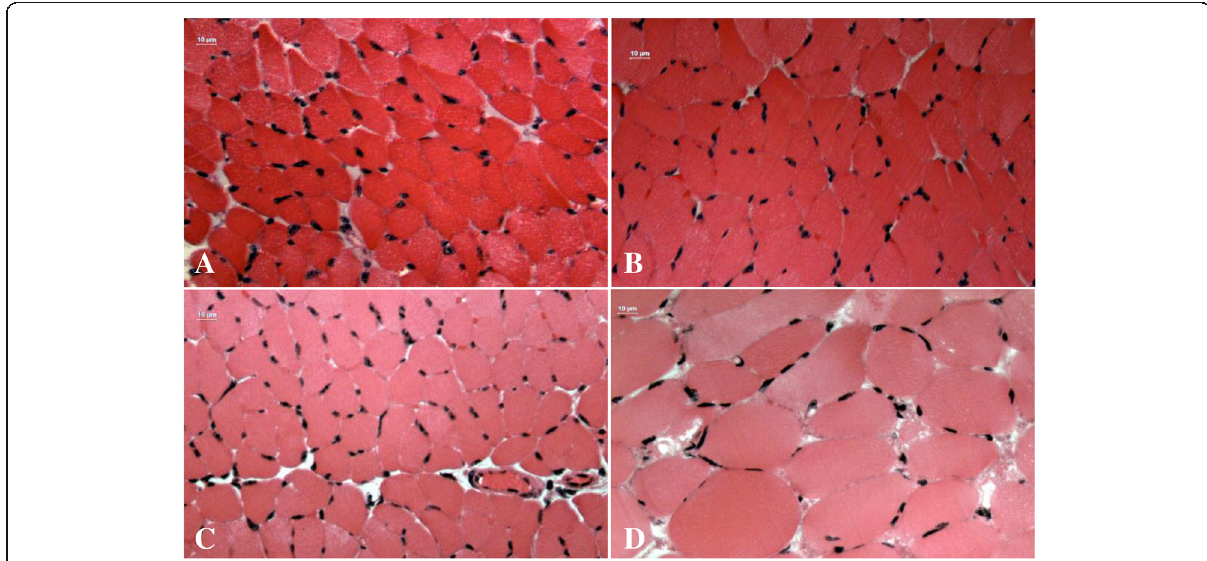
Fig. 8 Light micrographs of mouse diaphragm muscles submitted to hematoxylin and eosin staining. Control muscle ( a ) and muscles exposed to extracts of C. gigantea (body-wall) ( b ), C. gigantea (total) ( c ) and S. helianthus ( d ). Note the general normal appearance of fibers with polygonal aspect (f) and endomysium (en). Muscle damage index of (C) and (D) (4.3 ± 1.3, n = 5 and 5.5 ± 1.1, n = 4, respectively) were not significantly different from that of (A) (2.0 ± 0.4, n = 5). However, muscle damage of B (5.9 ± 0.8, n = 5) was significantly higher than that of A. (ANOVA, p